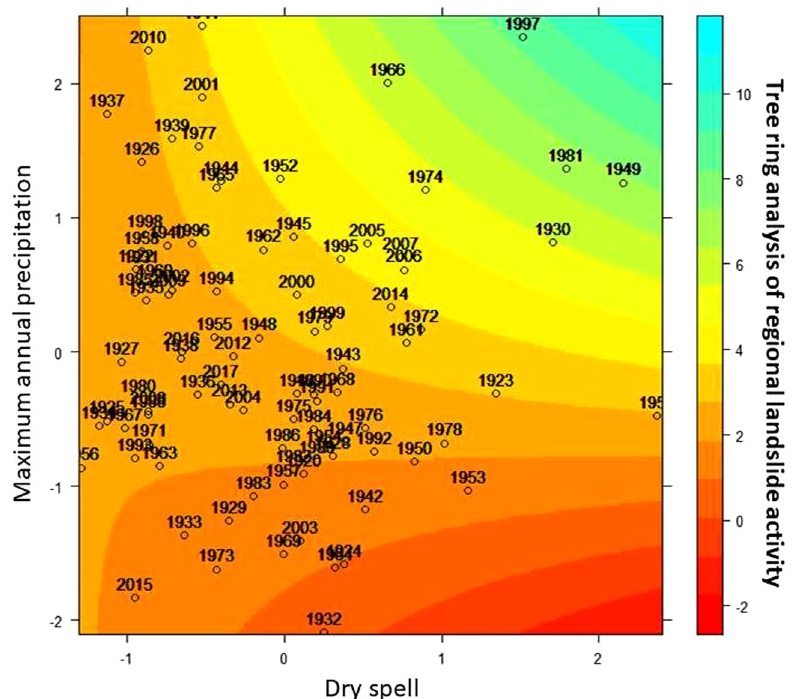
Figure 6. Predicted tree-ring disturbance induced by regional landslide activity is shown here as a function of maximum annual precipitation rate and dry spells by using a generalized linear mixed (GLM) model. The colour ramp indicates the predicted response of tree-growth disturbances to landslides activity. The labelled dots indicate landslide signals during specific years. The units for the maximum annual precipitation rate and dry spells have been standardized and are shown with